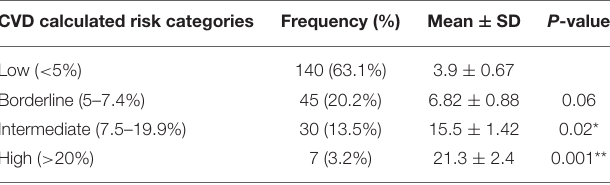
TABLE 2 | Cardiovascular calculated 10-year risk among female at Taibah